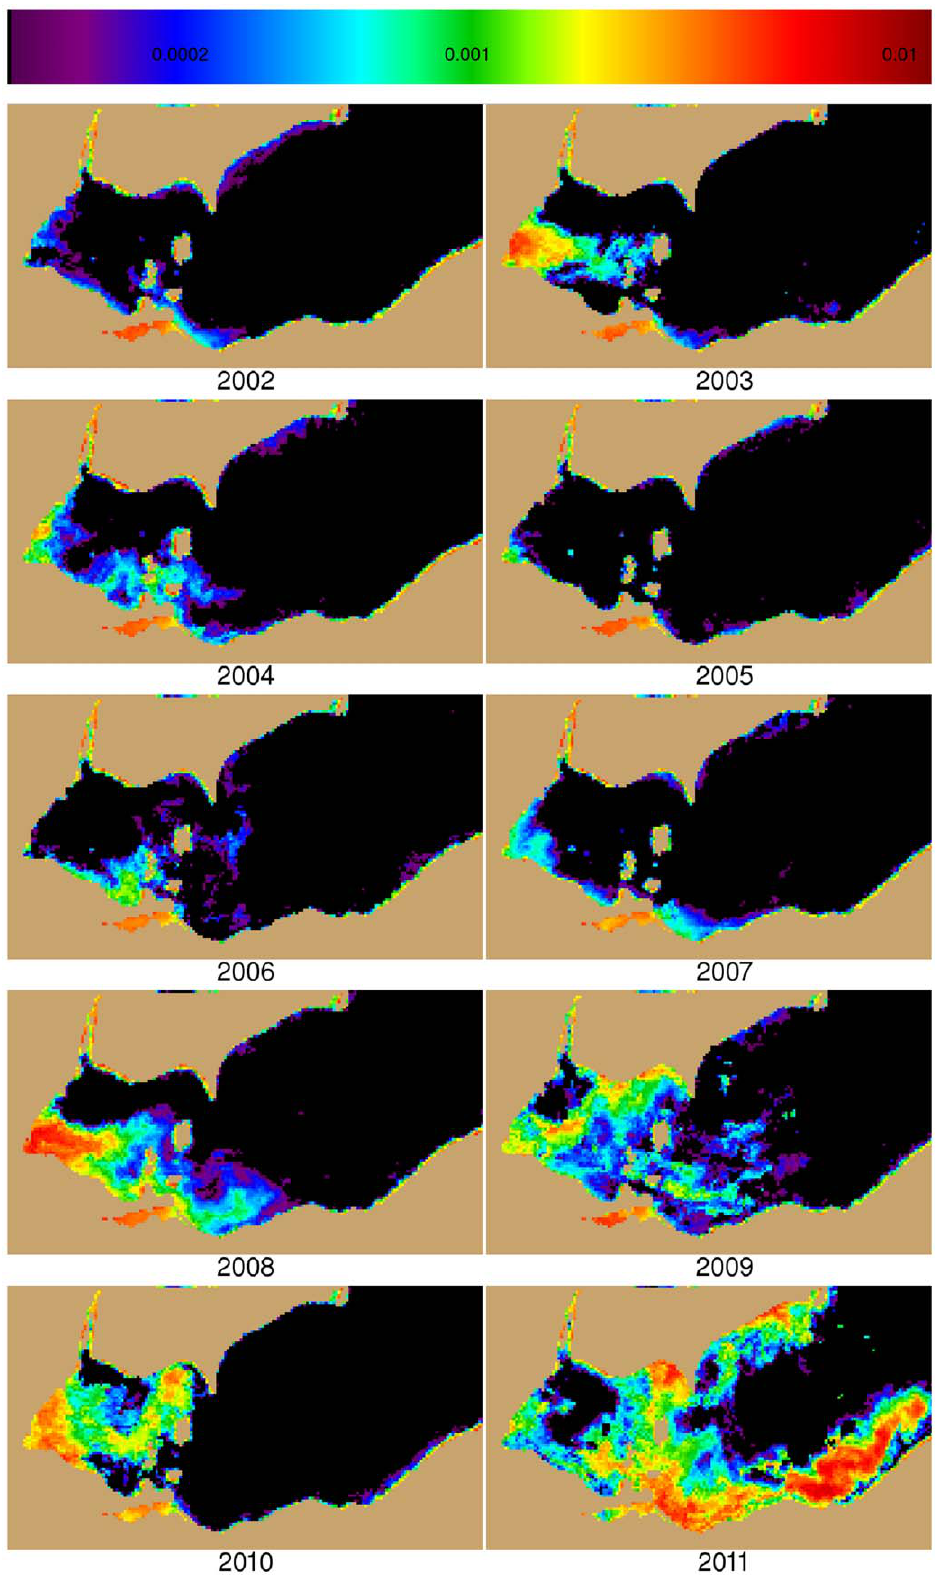
Figure 3. Mean of the three 10-day composites (identified by circles in Figure 2) used to compute intensities for each year for western Lake. Black indicates CI , =0. Brown is land. Maumee River input is the far western end of the lake (see Figure 1).